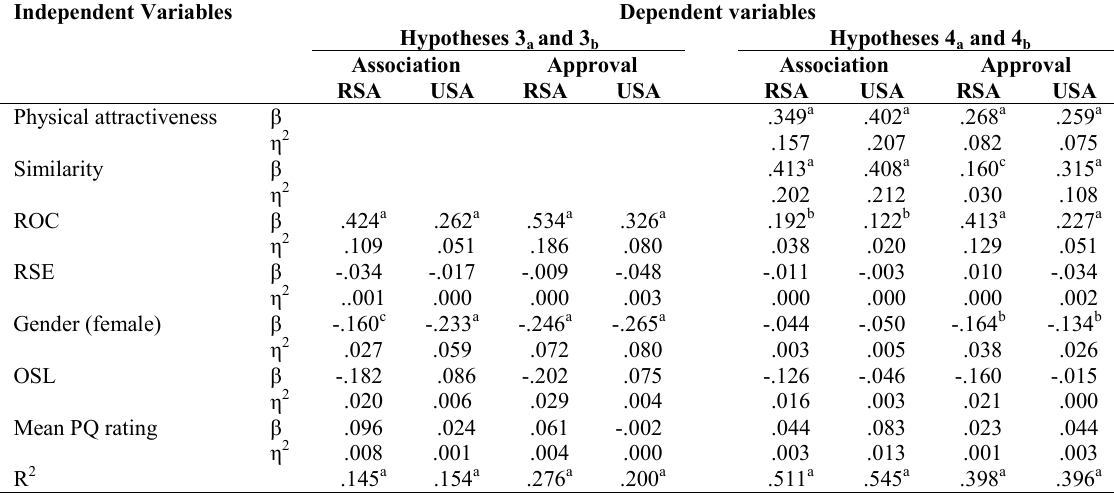
Table 3: Regression